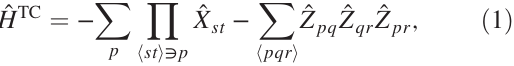
˜ G symmetry. Then we gauge the Z 2